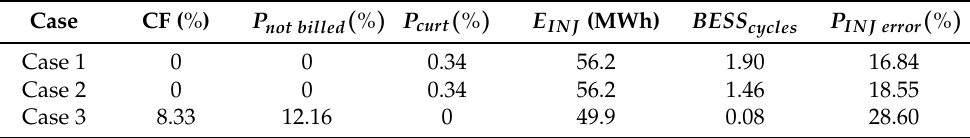
Table 4. Key Performance Indicators (KPIs) evaluation for Strategy